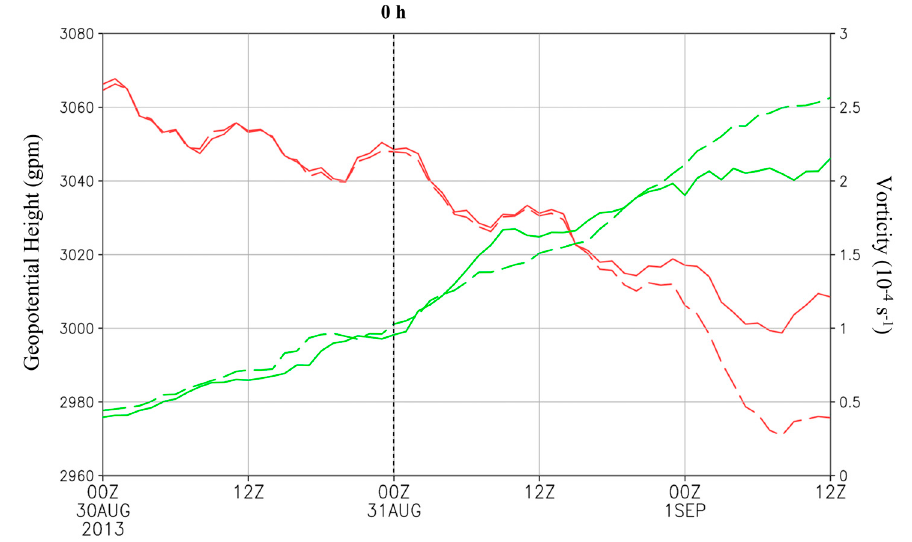
Figure A1. Time series of simulated 700-hPa geopotential height (red line; left-axis; gpm) and low-level vorticity averaged over a 2-deg radius from 925 hPa to 700 hPa (green line; right-axis; 10 − 4 s − 1 ) for CTRL (solid line) and RMTW (long dash). The disturbance center uses the 700-hPa circulation center.